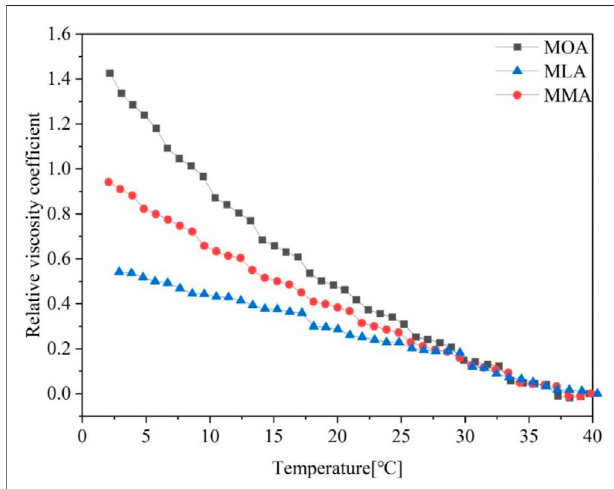
FIGURE 9 | Relative viscosity coef fi cient-temperature images of three magnetic fl